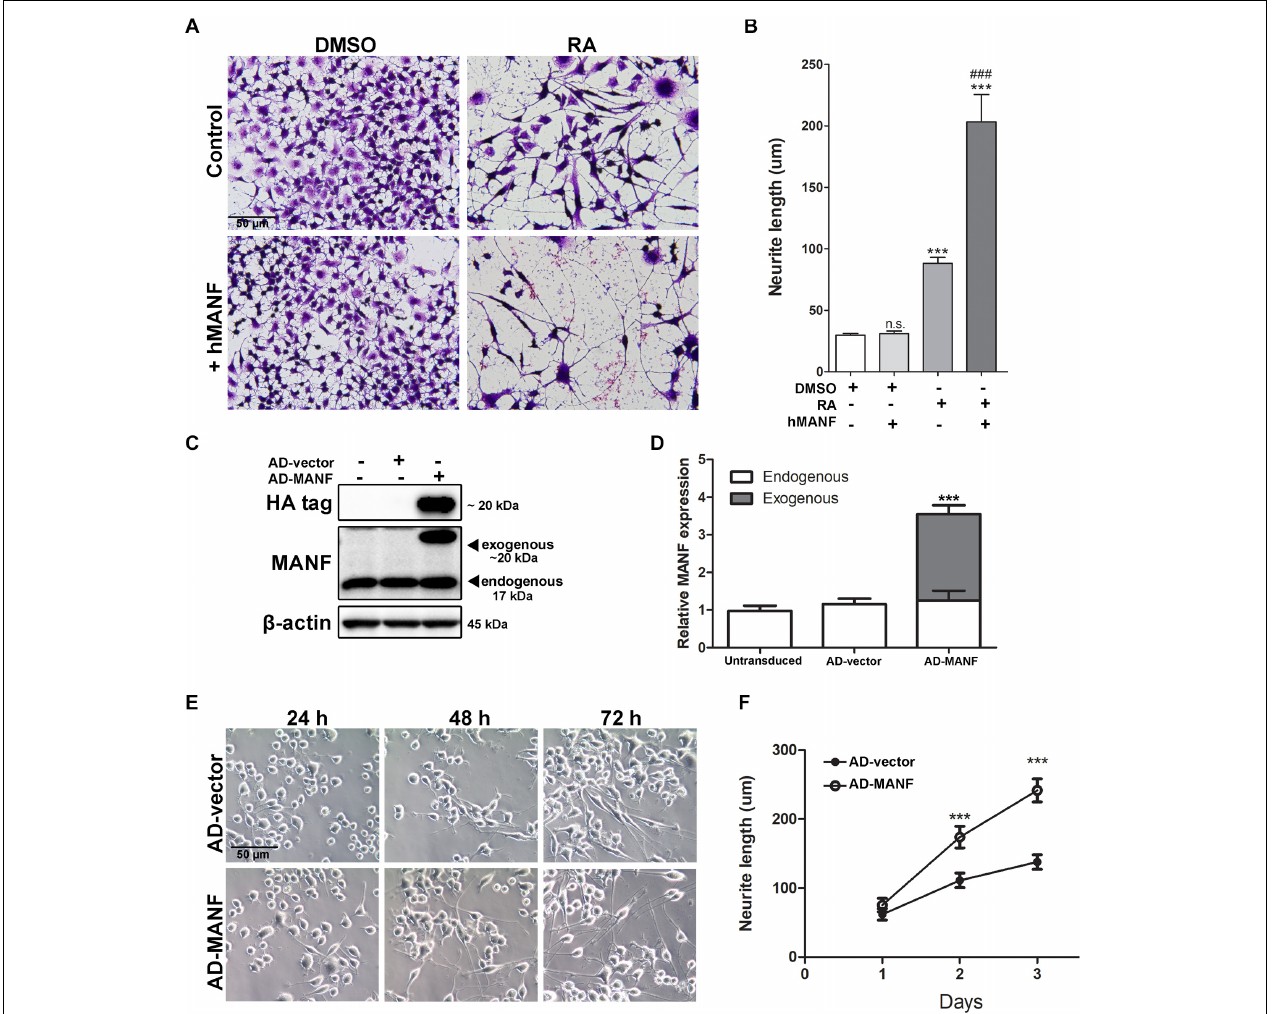
FIGURE 4 | MANF overexpression facilitates RA-induced neurite outgrowth. (A) Representative images of N2a cells treated with DMSO or RA for 3 days with or without addition of recombinant hMANF (100 ng/ml). Cells were fixed and stained with crystal violet for visualization. (B) Average neurite length was measured, and analyzed by One-way ANOVA followed with the Tukey’s post hoc test, *** P < 0.0001 and n.s. not statistically significant compared to DMSO treated cells, ### P < 0.0001 compared to RA treated cells. The data were expressed as the mean ± SEM of three independent experiments. (C) Cells were lysed 48 h after adenovirus transduction and subjected to immunoblot to determine levels of MANF and HA tag expression. The size of the proteins (kDa) was labeled next to each band. (D) Endogenous and exogenous MANF protein levels were quantified and normalized to β -actin. The data were analyzed by Student’s t test, *** P < 0.0001. The data were expressed as the mean ± SEM of three independent experiments. (E) Representative images of AD-vector and AD-MANF transduced cells treated with RA for 24, 48, and 72 h. (F) Average neurite length of AD-vector and AD-MANF transduced cells after RA treatment was determined, and analyzed by Two-way ANOVA followed with the Bonferroni’s post hoc test, *** P < 0.001. The data were expressed as the mean ± SEM of three independent